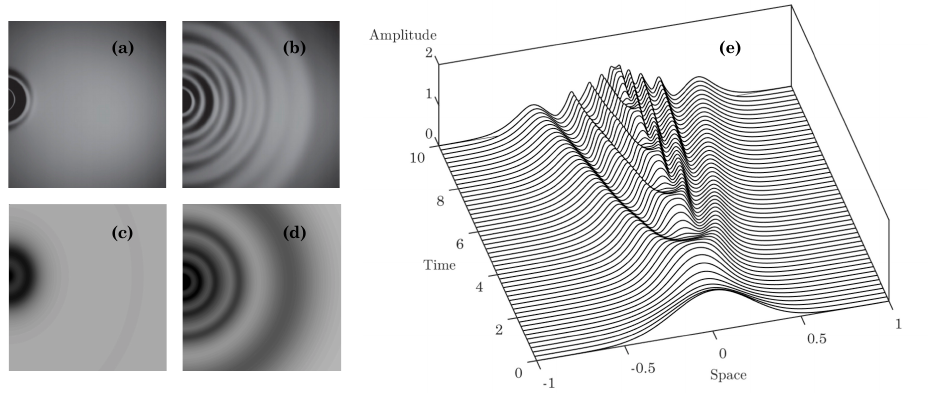
Figure 5. ( a , b ): Photographs of the wave field generated by a falling steel ball on a vertically oscillating liquid bath, at times t = 51 ms ( a ) and t = 173 ms ( b ) after the collision—( a , b ) are presented in [15]. ( c , d ): Simulations of the wave field generated from nonlinear triad resonance of two surface waves propagating in opposite directions, and a compression mode oscillating in the vertical direction, at times T = 17 ( c ) and T = 51 ( d ). ( e ): Evolution of the surface wave amplitude during the resonant